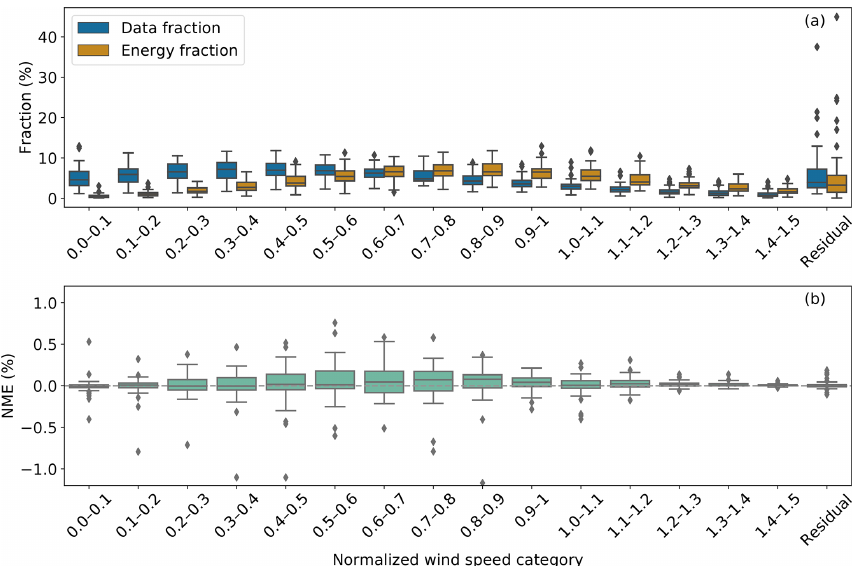
Figure 7. Similar to Fig. 6, but for normalized wind speed bins in the outer range, without the colored dots in Fig. 6 (a) . For clarity, the submissions are aggregated as box plots and not displayed as dots in (a) . For each submission, the sums of the data fractions, energy fractions, and NMEs from all the bins, including the residual, equal those of the outer range (in Fig. 6).